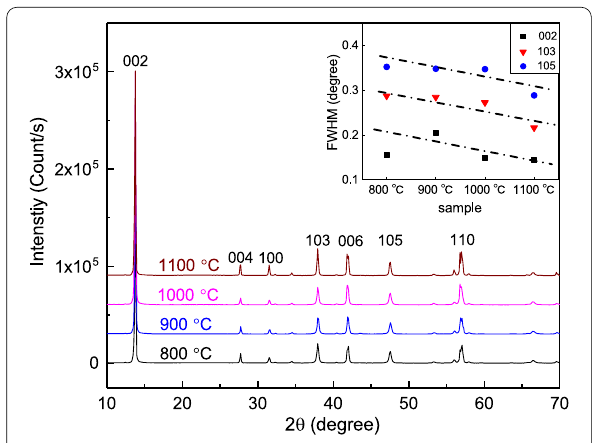
Fig. 1 The XRD spectrum of the MoSe 2 /WSe 2 powder at different thermal annealing temperatures. No obvious peak shift was observed. The inset reveals that the full‑width at half height of XRD peaks slightly decrease at higher annealing